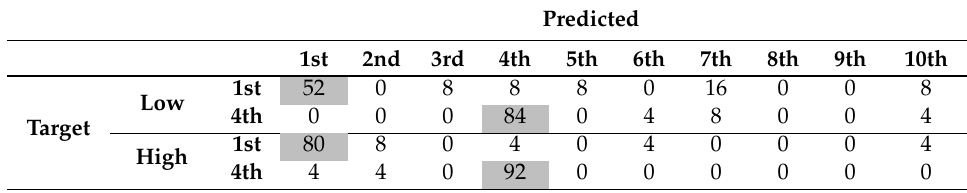
Table 4. Confusion matrix of corrective focus identification performed by the models. In this table, we only show the accuracies of the AP-initial positions for the sake of simplicity. Numbers highlighted in gray indicate correct identification rates. The top panel shows the results of the model trained with digit strings containing a L-toned focused digit, and the bottom represents the performance of the model trained with a H-toned focused digit. We calculated the prediction rates from the sum of all CVs.